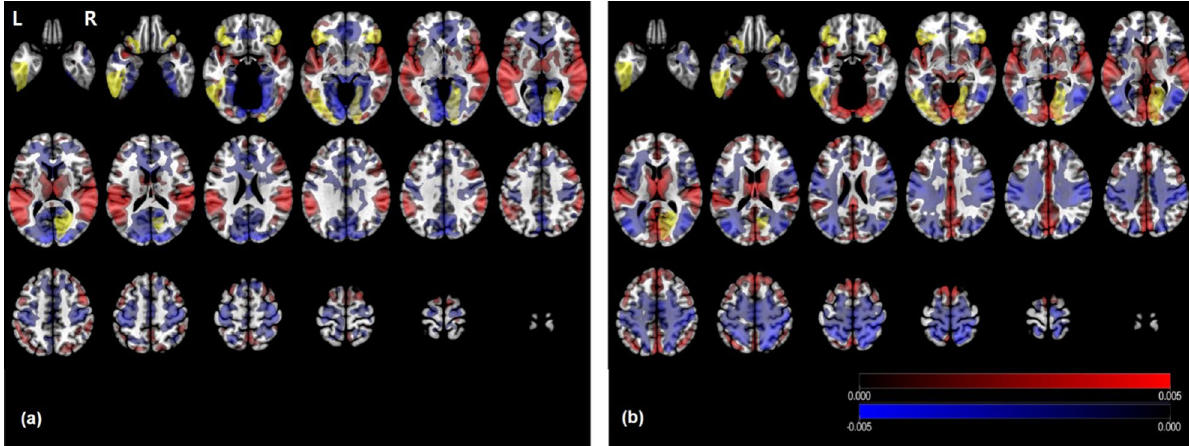
Figure 4. Representative PC2 images of participants in the PI and HC groups. Voxel-based PC2 images were generated using PC2 loadings resulting from mean contrast images of picture, sound, and Stroop stimuli for participants in the PI ( a ) and HC ( b ) groups. Red represents positive loadings and blue negative loadings, indicating that neuronal activation was inversely correlated in these structures. Yellow represents selected ROI- based features by LASSO. Spatial pattern showed the most significant overlap in sound BOLD activation.